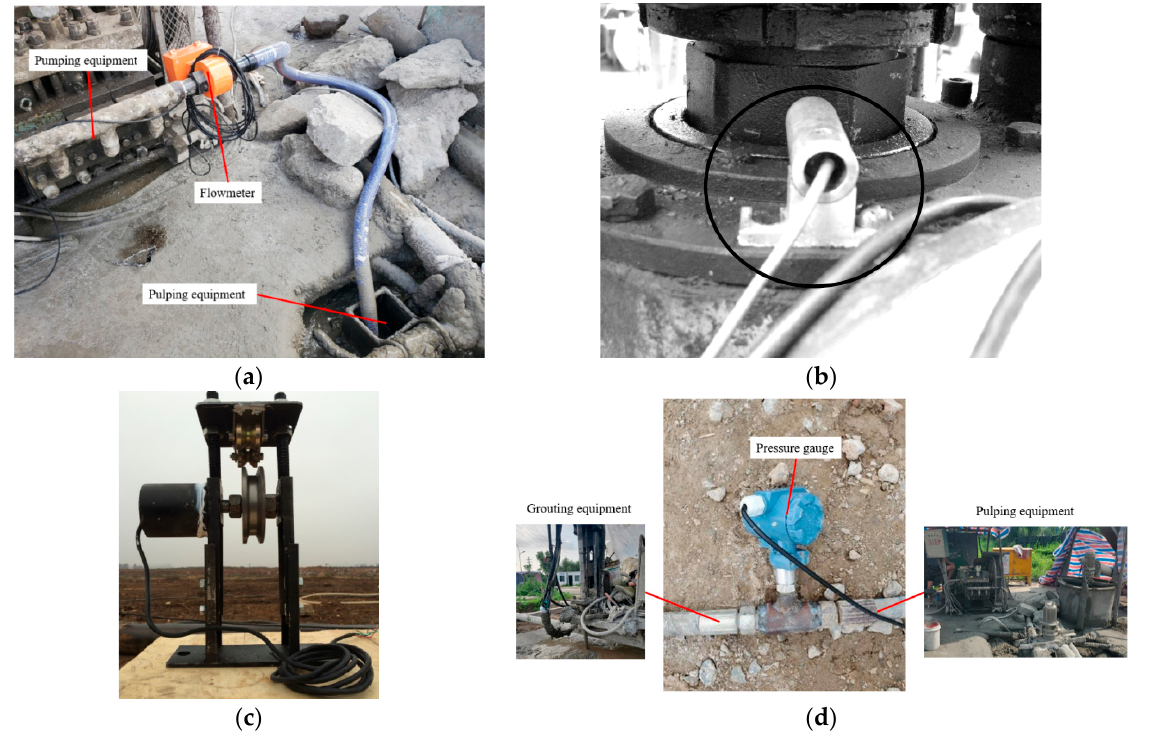
Figure 13. Installation of monitoring sensors. ( a ) Flowmeter. ( b ) Speed sensor. ( c ) Depth sensor. ( d ) Pressure sensor.